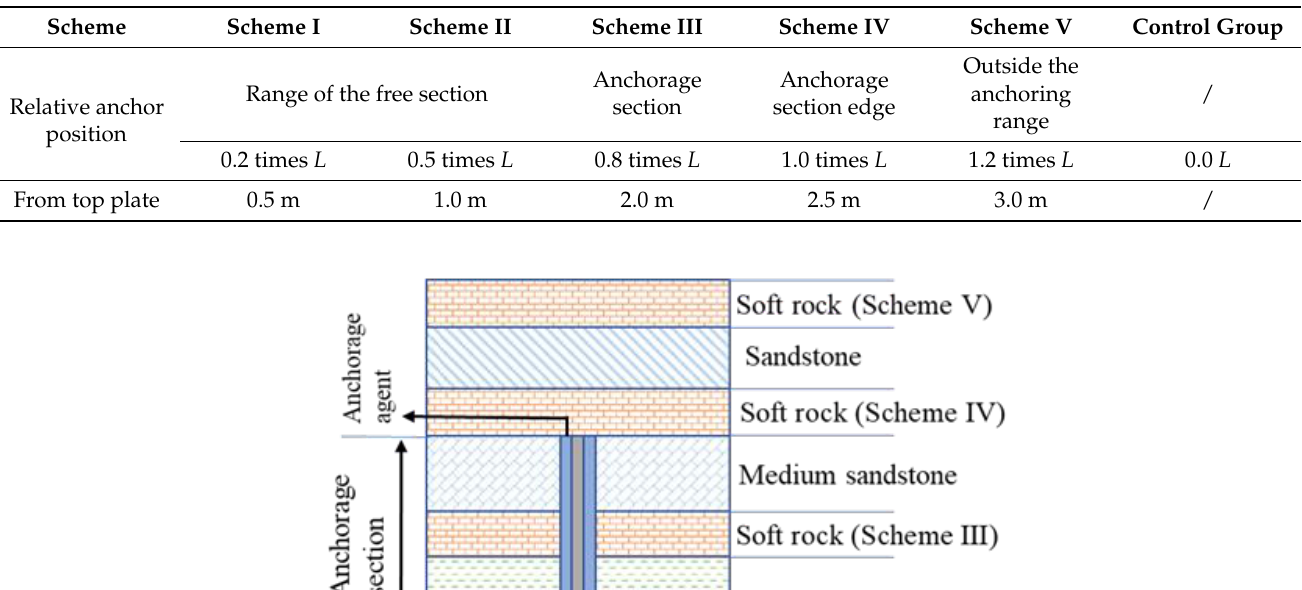
Table 2. Model Scheme.